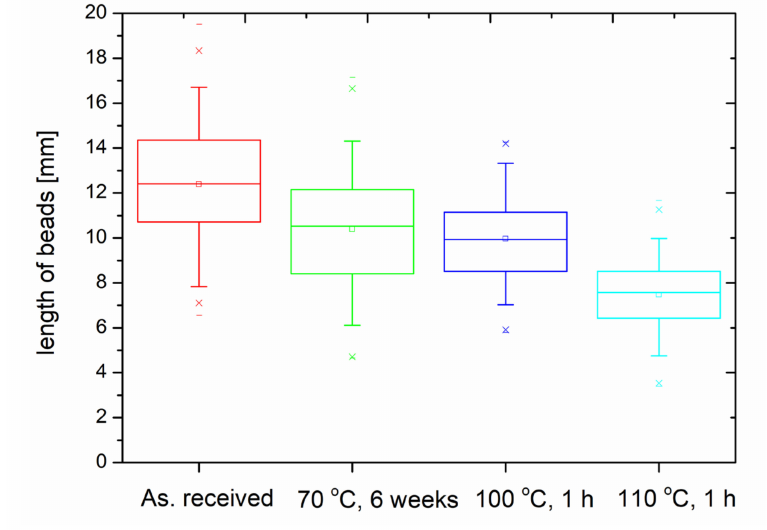
Figure 4. The results of the beads analysis with the box chart method.